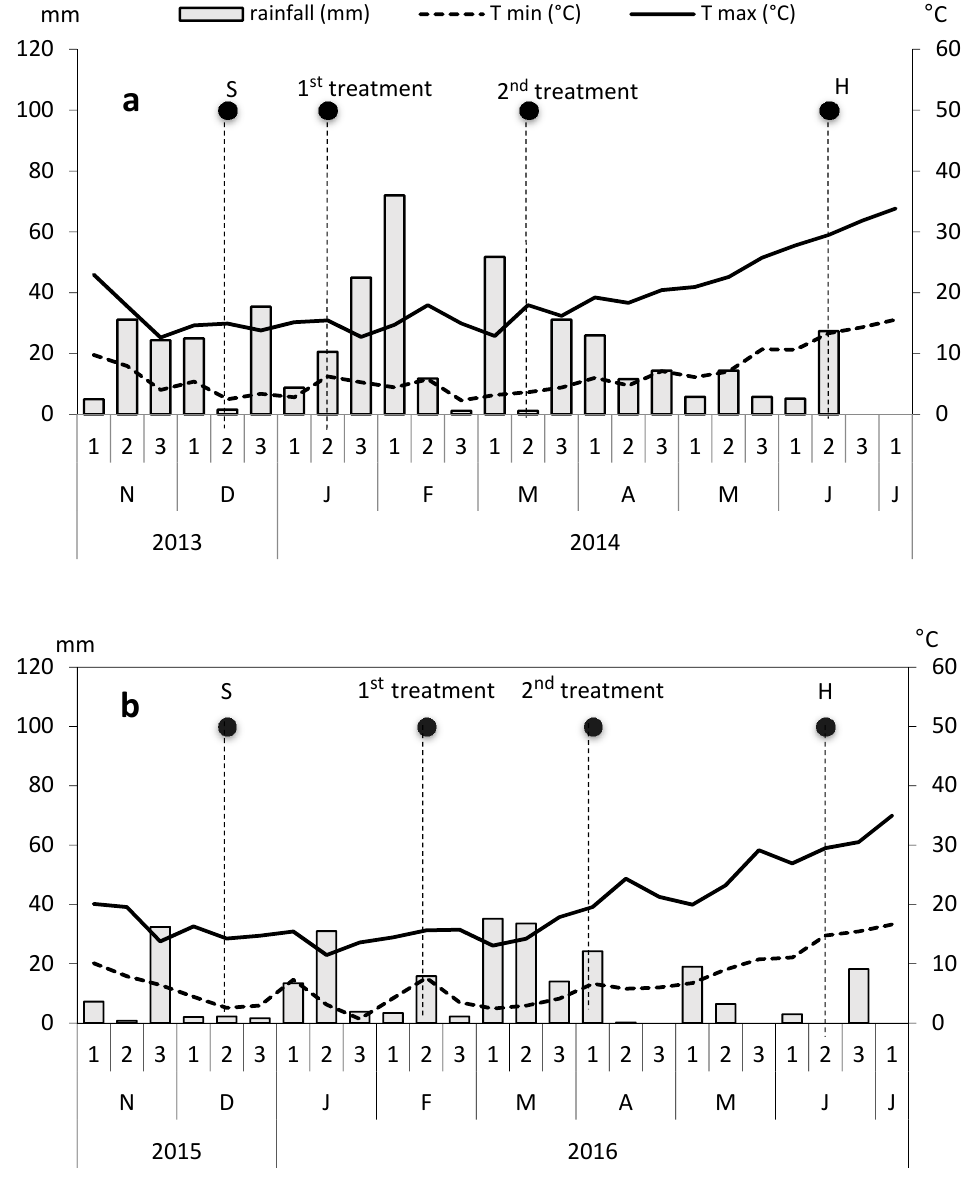
Figure 1. Cumulated rainfall (mm; bars) and mean maximum (°C; solid lines) and minimum (°C; dotted lines) temperatures recorded in 2013–2014 (a) and 2015–2016 (b) at Sparacia (Cammarata, AG, Italy). S: Sowing time; H: Harvest time; first treatment, second treatment: Dates of the two treatments with plant extracts. Data are reported as ten day values from November (N) to July (J) in both trial years.